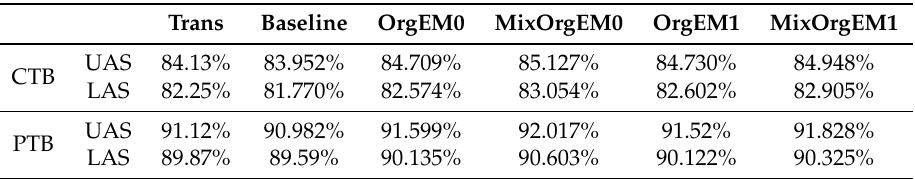
Table 3. Results of the test corpus.